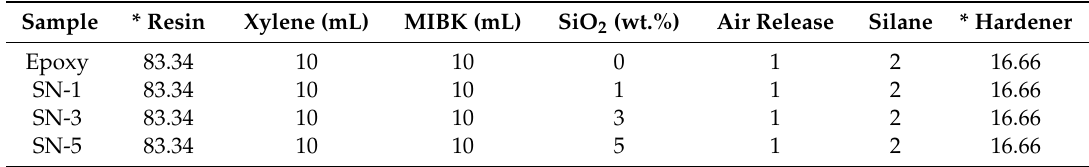
Table 1. Formulation of epoxy / SiO 2 nanoparticle incorporated